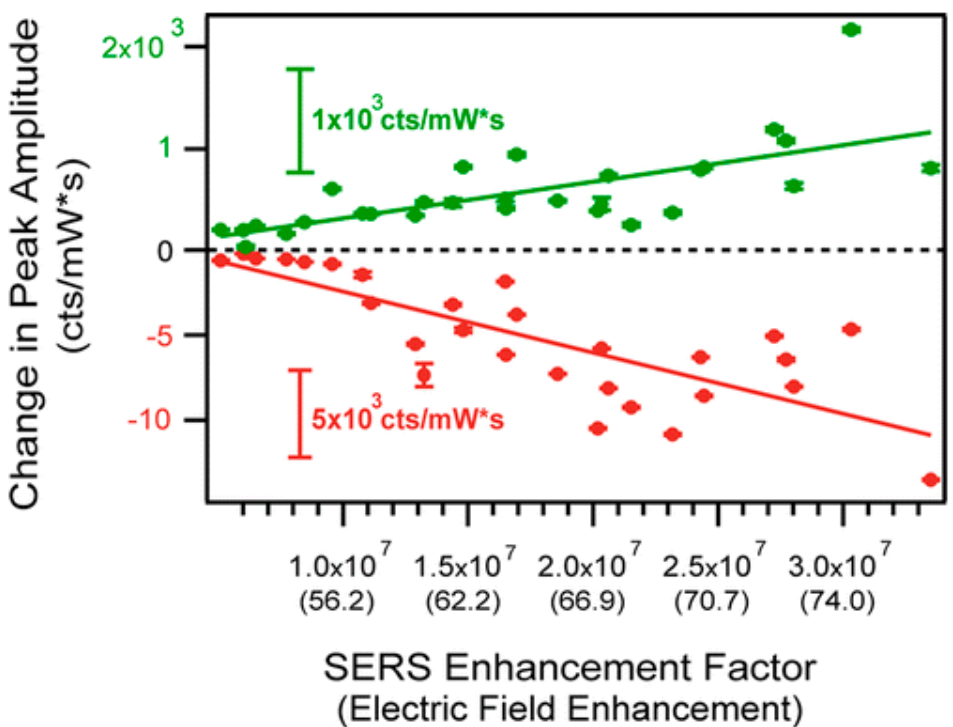
Figure 8. Total change in the reactant (red) and product (green) peak amplitudes as a function of SERS EF. The y -axes for reactant and product are different to clearly highlight the correlation with the SERS EF [45].